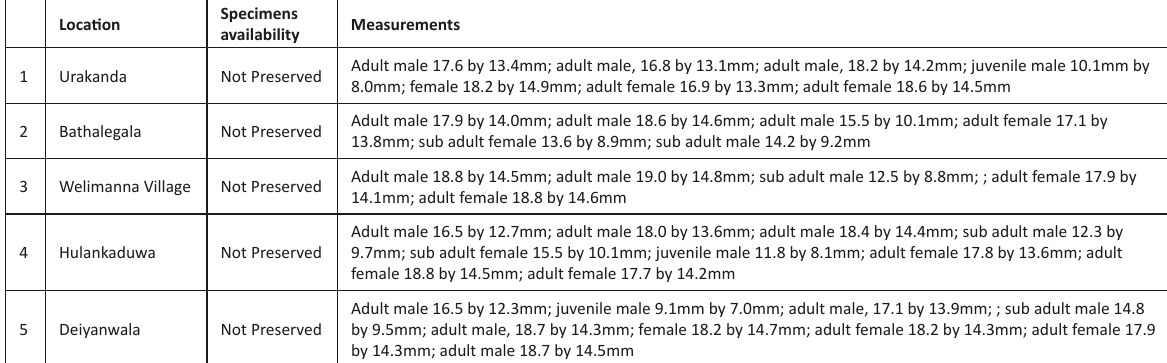
Table 1. Material examined in the present study, the measurements (carapace width and carapace length respectively) of C.